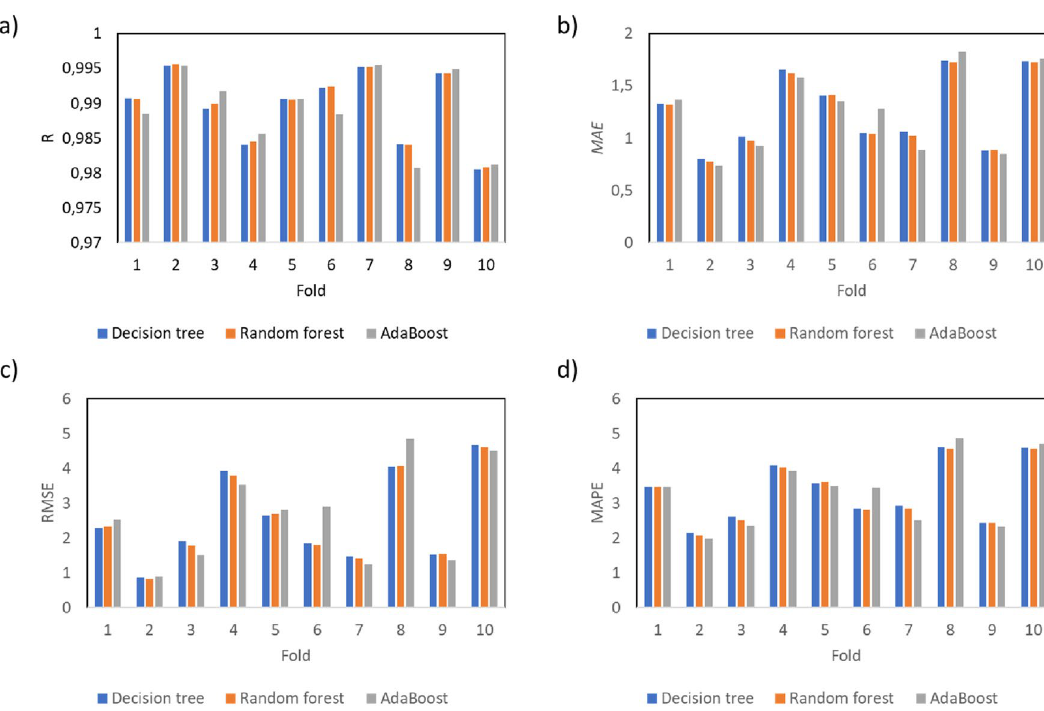
Figure 6. The performance of the analyses evaluated by ( a ) the linear coefficient of correlation, ( b ) mean average error, ( c ) root mean square error and ( d ) mean average percentage